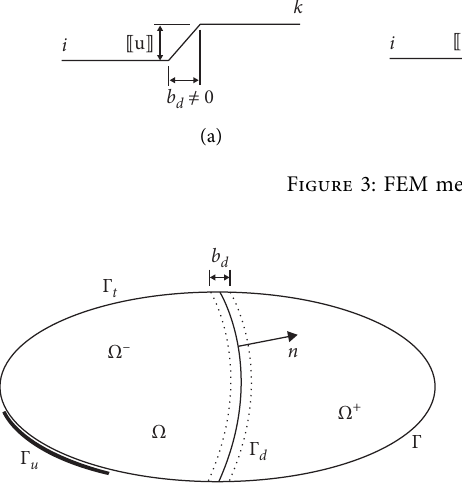
Figure 4: Continuum solid crossed by a discontinuity Γ